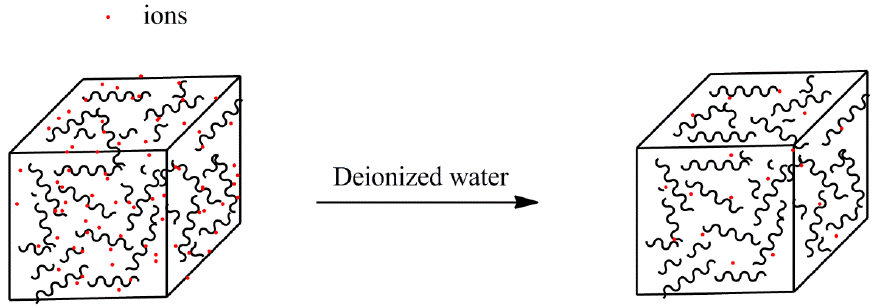
Figure 2. The simulation of desorption of γ -PGA/ ε -PL hydrogels in deionized water.